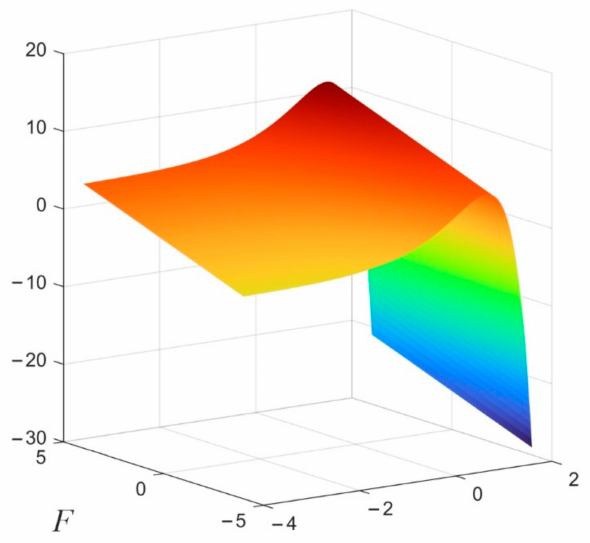
= 1 . Here, F ≡ w ( ξ , η ) 3 16 α 11